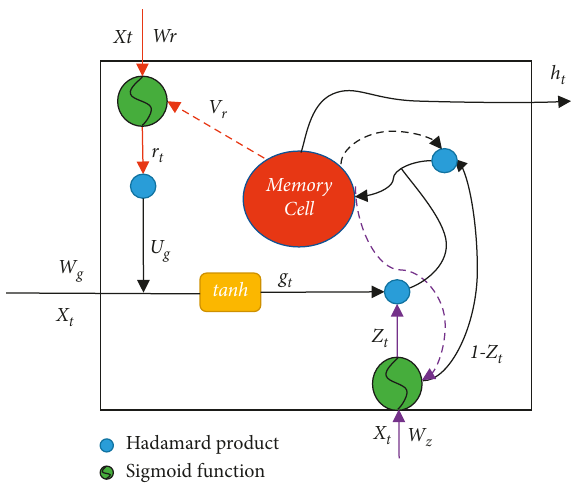
Figure 1: The structure of